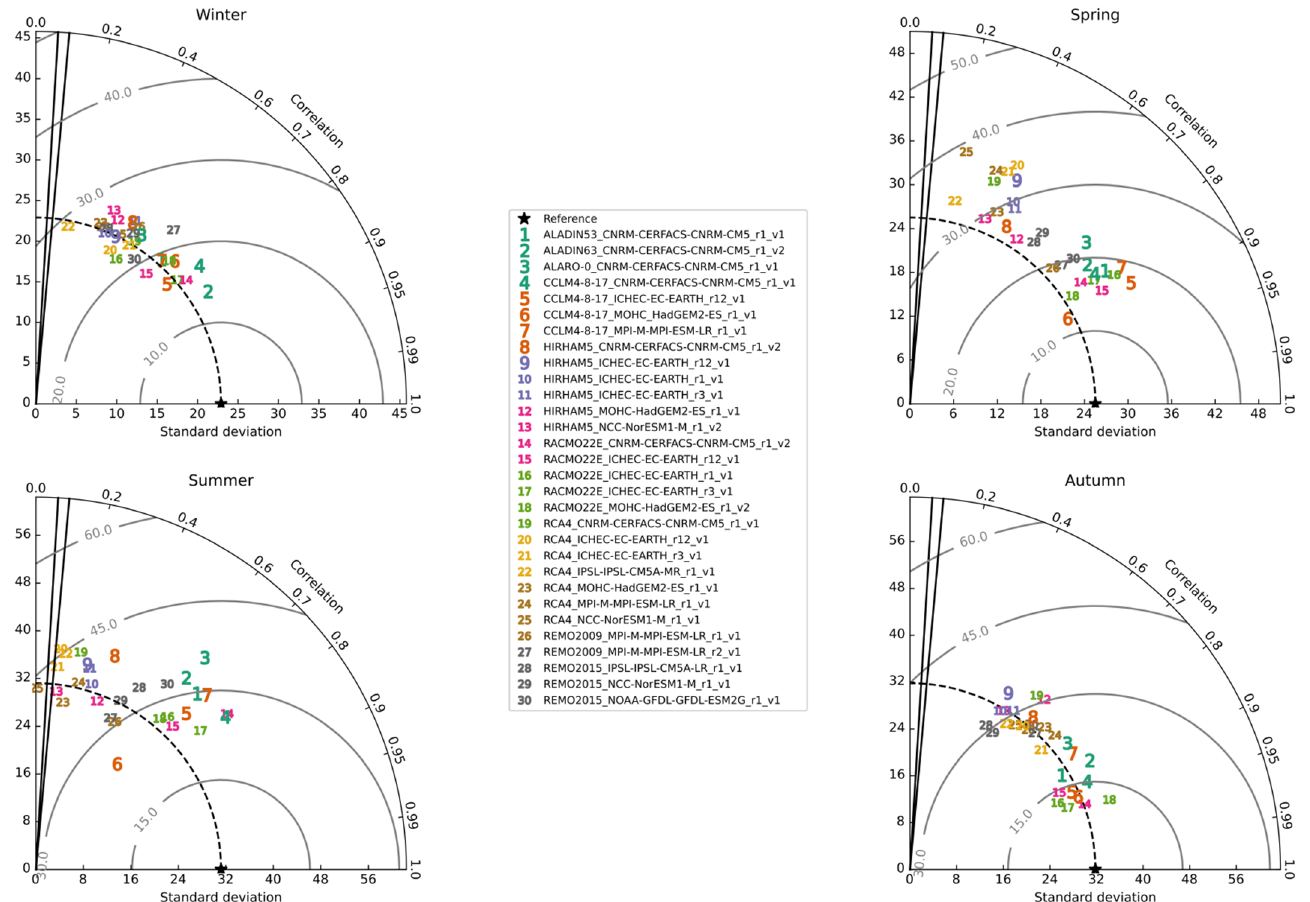
Figure 9. Taylor diagrams of seasonal (1971–2000) precipitation showing standard deviation (mm/season), centered RMSE (mm/season), and spatial correlation for each EURO-CORDEX GCM–RCM simulation versus E-OBS observations across the Pannonian Basin. The four panels refer to the four seasons defined as winter (DJF), spring (MAM), summer (JJA), and autumn (SON). The observed field is labeled with a star symbol. The dotted line depicts the contour of the reference standard deviation (the observed field). The RMSE contours are grayed out. The 95th and 99th significance levels are represented by the correlation rays on the left and right, respectively.